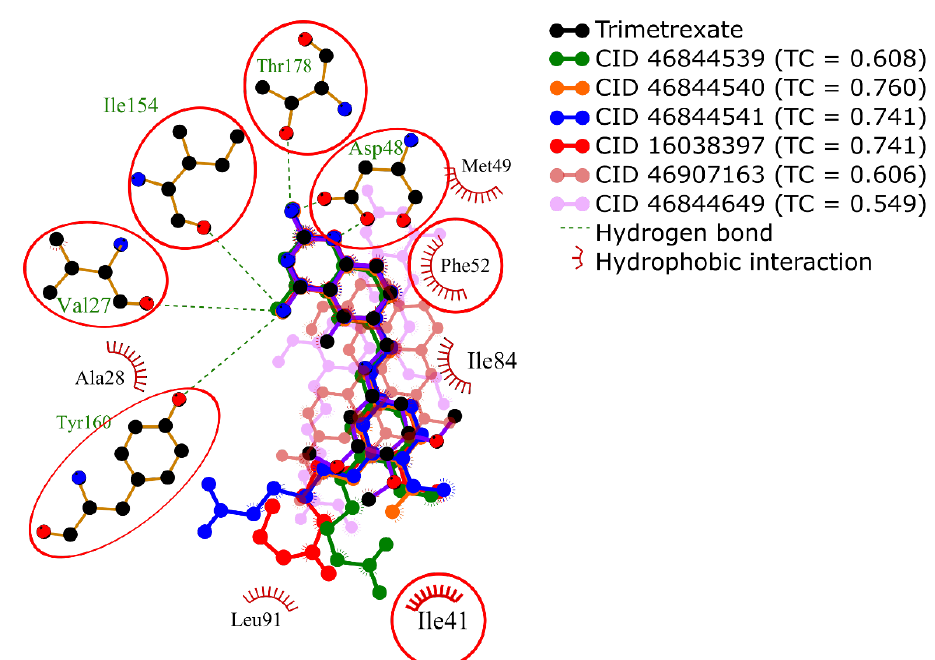
Figure 4. Superposition of 2D diagrams of docked conformations of each known inhibitor with the highest Tanimoto coe ffi ents. Interactions with residues in red circles were highly conserved.